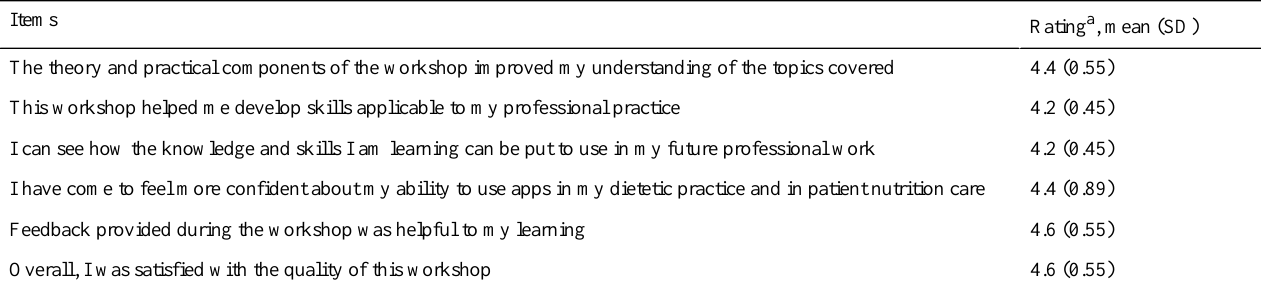
Table 5. Dietitian satisfaction with the educational and skills training workshop component of the intervention.